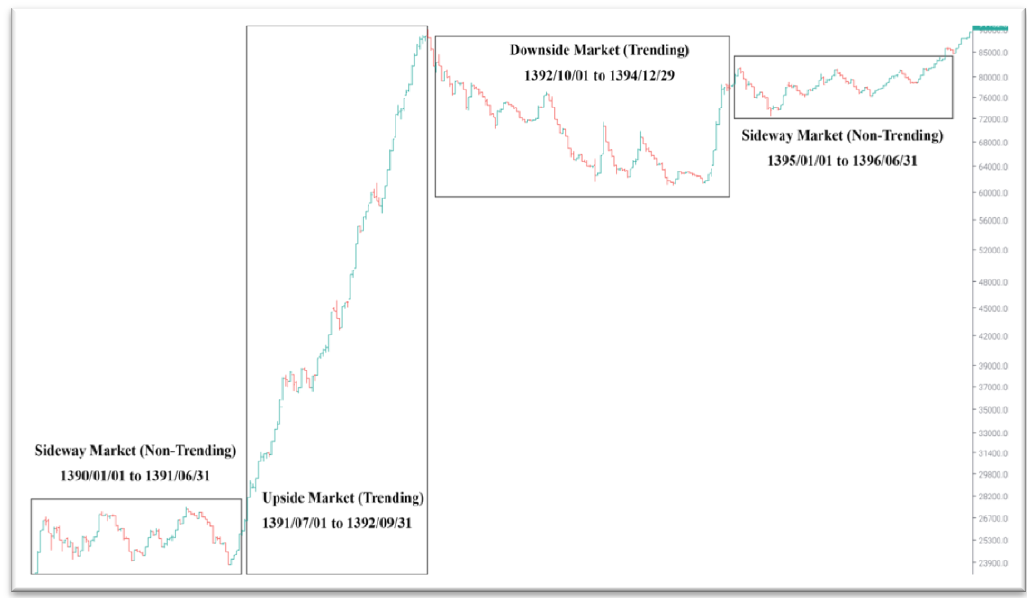
Figure 5. Classification of TEDPIX